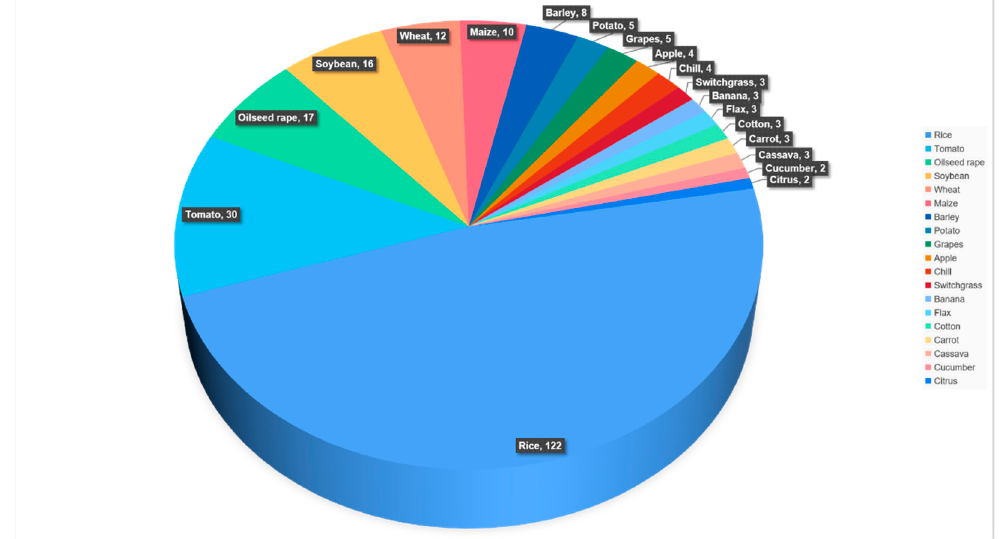
Figure 3. The number of genes modified using CRISPR/Cas system with the aim of crop improvement. Table for the period from 2016 till 2020.